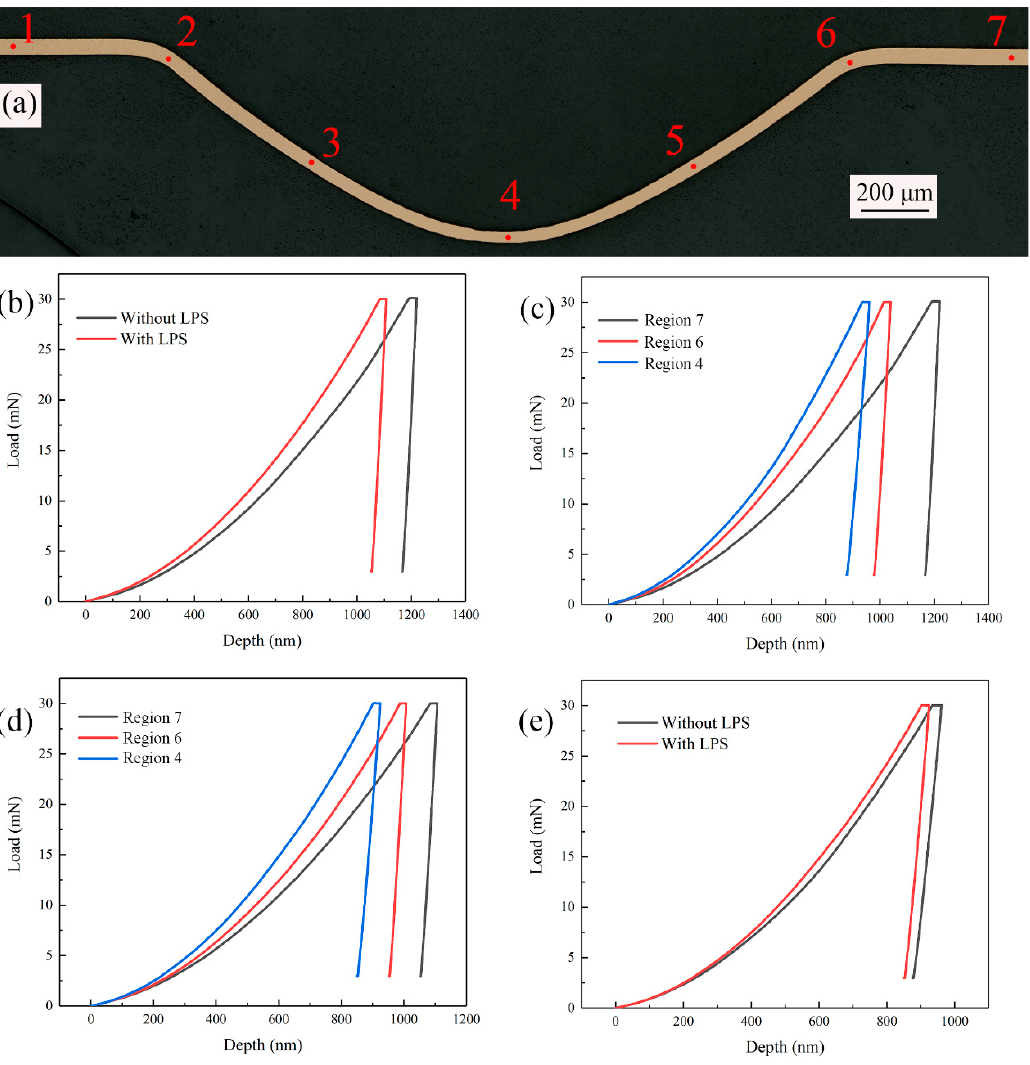
Figure 16. ( a ) Schematic diagram of measurement regions; ( b ) load-depth curves of unformed regions; ( c ) load-depth curves of different regions of the bulging sample without LPS; ( d ) load-depth curves of different regions of the bulging sample with LPS; ( e ) load-depth curves of bulging central regions.